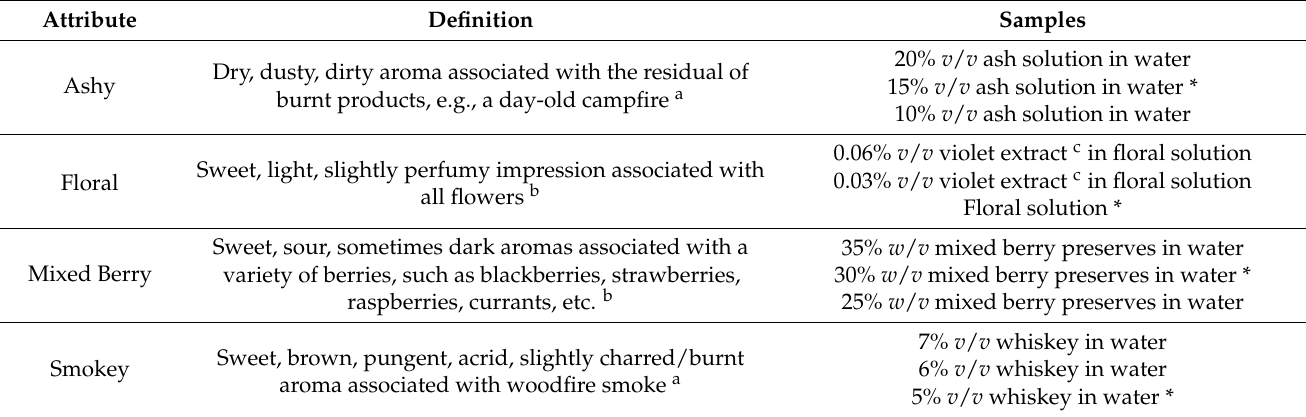
Table 1. Attributes analyzed across all studies with definitions provided during JAR evaluation and concentrations (% v / v or w / v ) of all samples